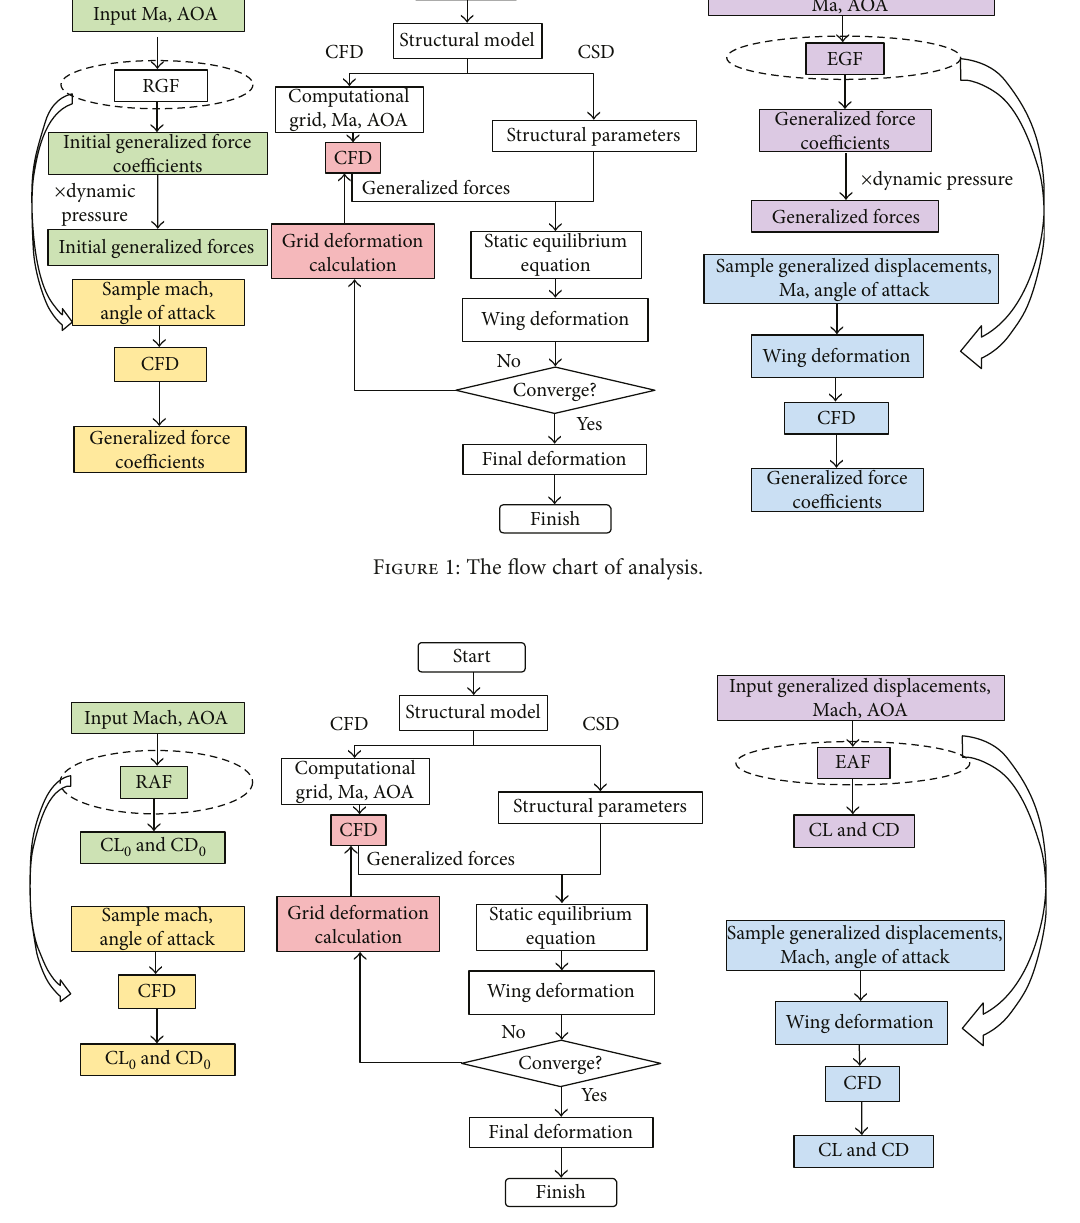
Figure 2: The fl ow chart of predicting the aerodynamic force coe ffi cients during the